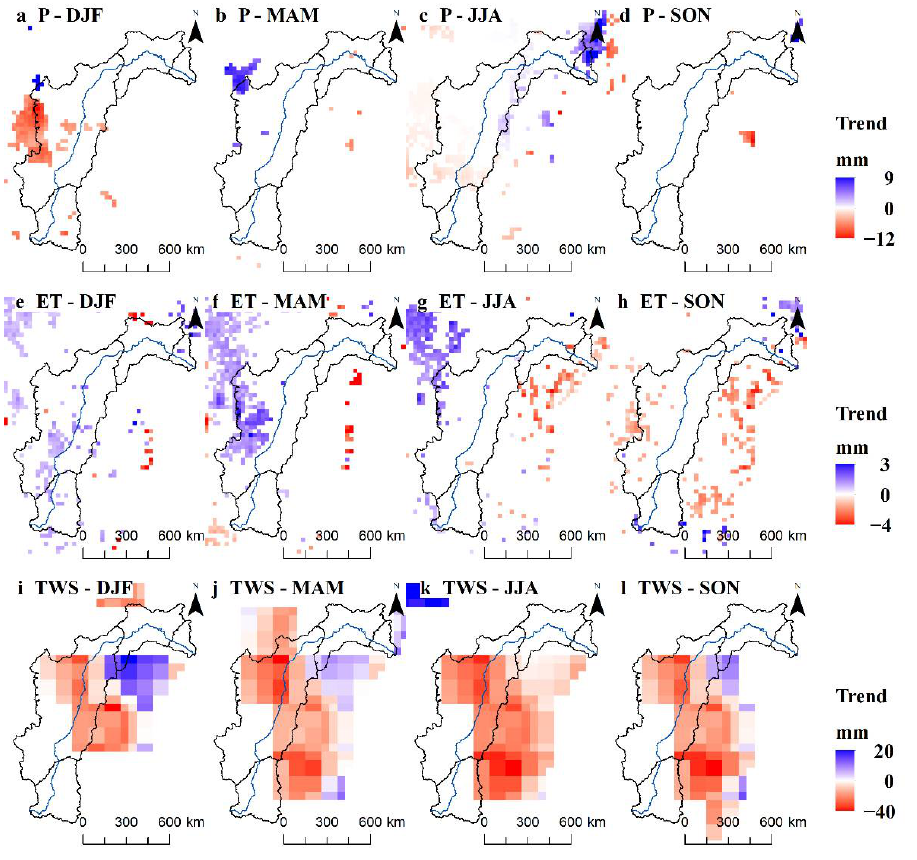
Figure 5. Seasonal trend magnitude: ( a – d ) precipitation (P), ( e – h ) evapotranspiration (ET), and ( i–l ) terrestrial water storage change (TWS), and their magnitudes over the Sao Francisco Basin. DJF = December, January and February; MAM = March, April and May; JJA = June, July and August; and SON = September, October and November. Trends were assessed using the Mann − Kendall and Theil–Sen’s slope estimator at 0.05 of the significance level. White color means a nonsignificant